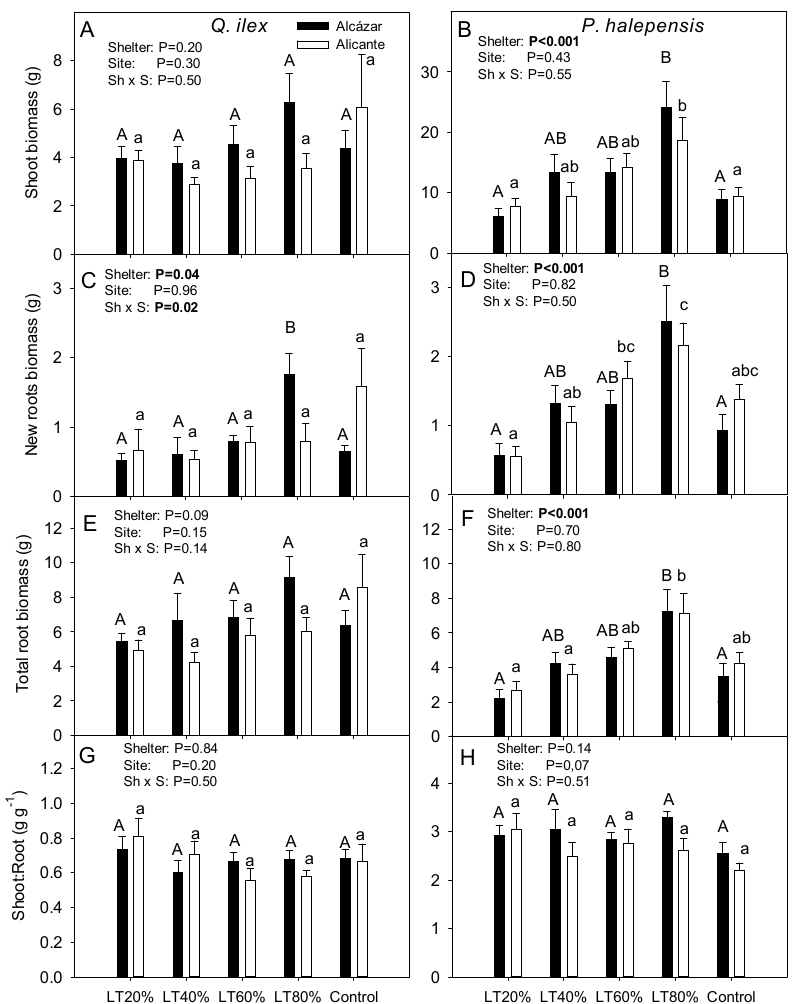
Figure 3. Mean values ( n = 6–10) of shoot ( A , B ), newly emerged root ( C , D ) and total root (emerged + plug, E , F ) biomass and shoot-to-root biomass ratio ( G , H ) of Q. ilex ( A , C , E , G ) and P. halepensis ( B , D , F , H ) seedlings harvested between first and second growing season (February 2011) for the different shelter treatments (control mesh plus a gradient of wall light transmissivity ranging from 20 to 80% of incident radiation) in each site (Alc á zar and Alicante). Error bars represent standard error. Different capital letters denote homogenous groups of shelter treatments within Alc á zar, while small letters apply to Alicante (Tukey, α = 0.05). For each variable and species, the results of the two-way ANOVA (Shelter, Site) are depicted in the corresponding